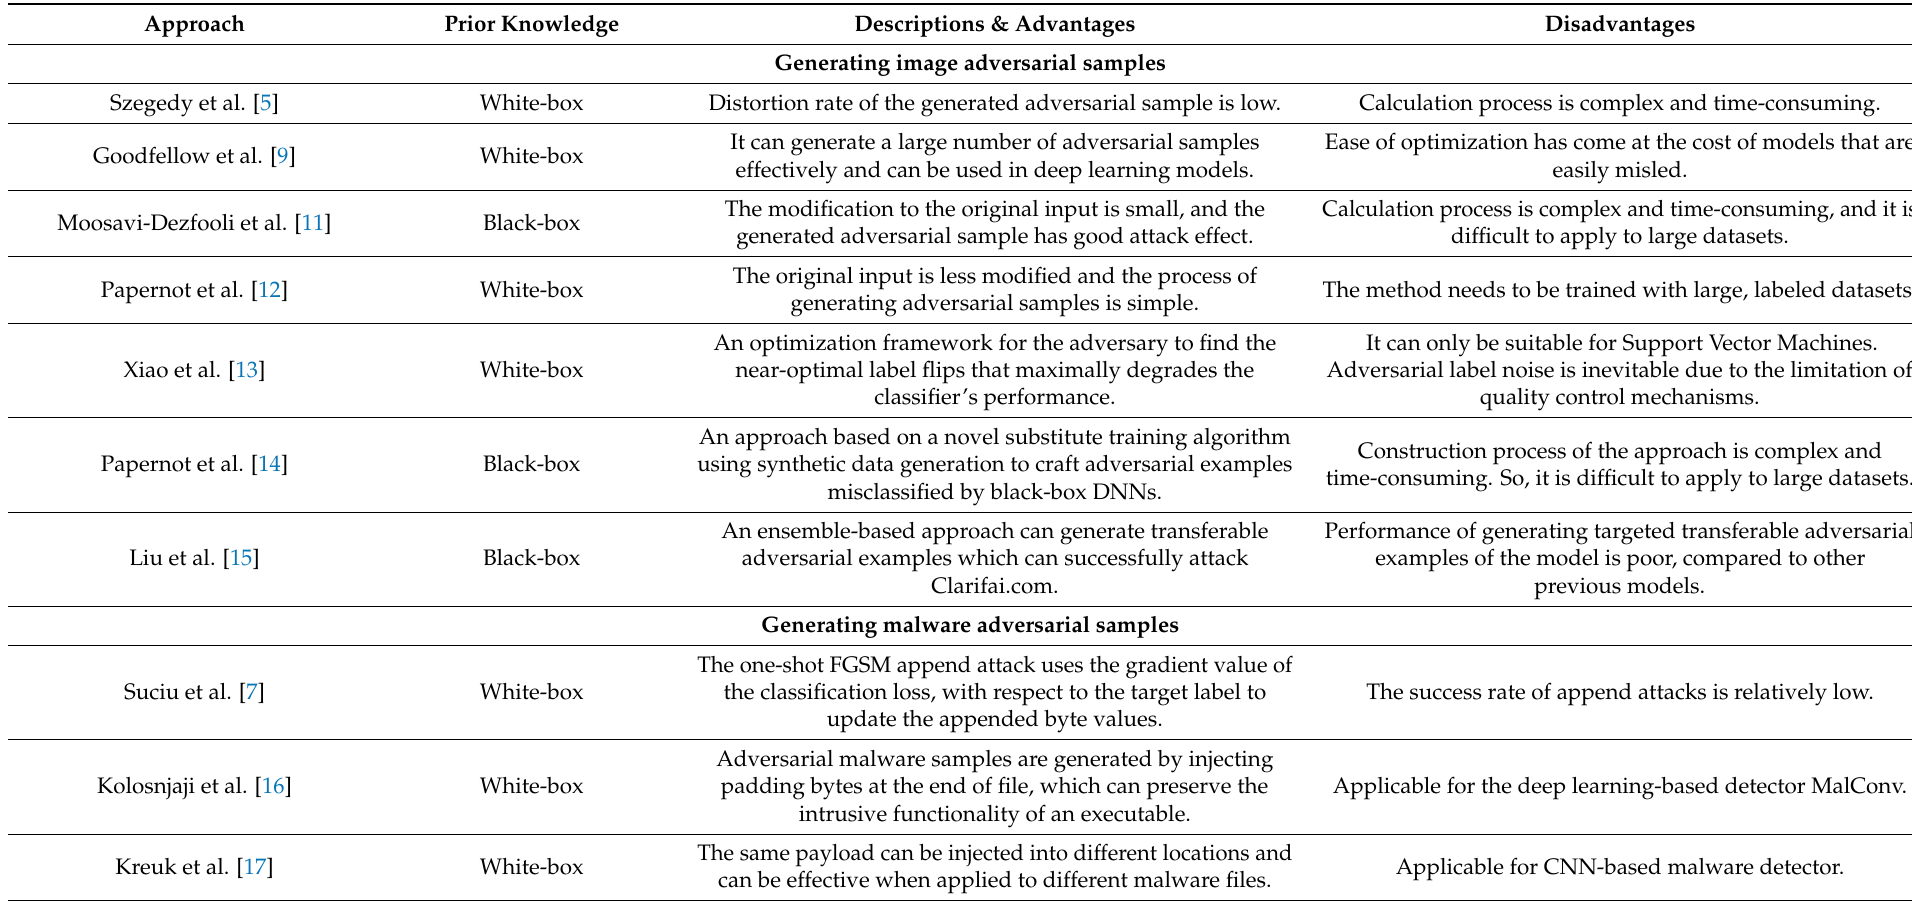
Table A1. Typical adversarial samples generation